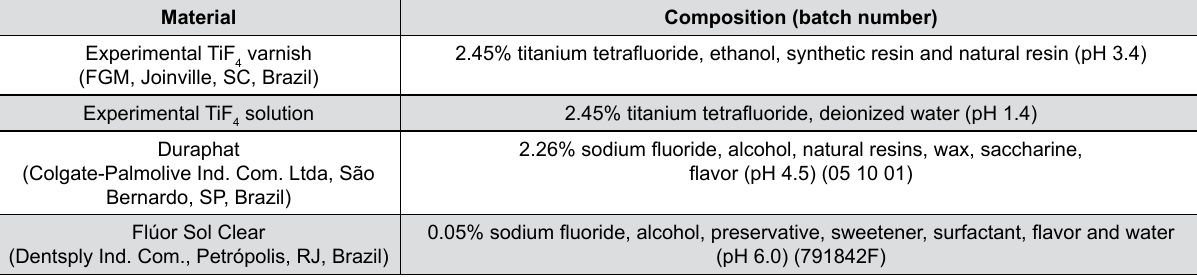
Figure 1- Compositions of fluoride agents tested in the